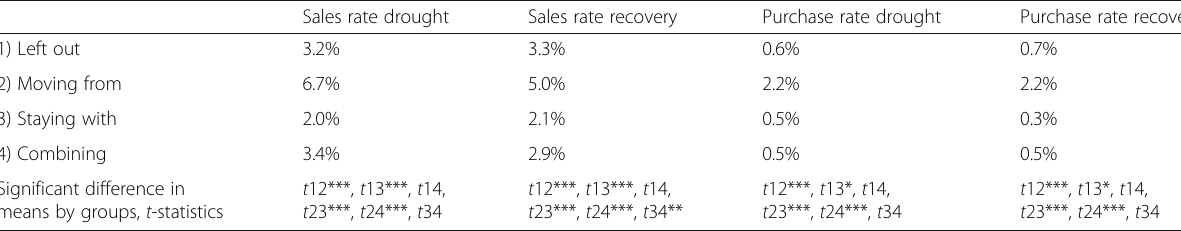
Table 5 Three month sales and purchase rates in drought and